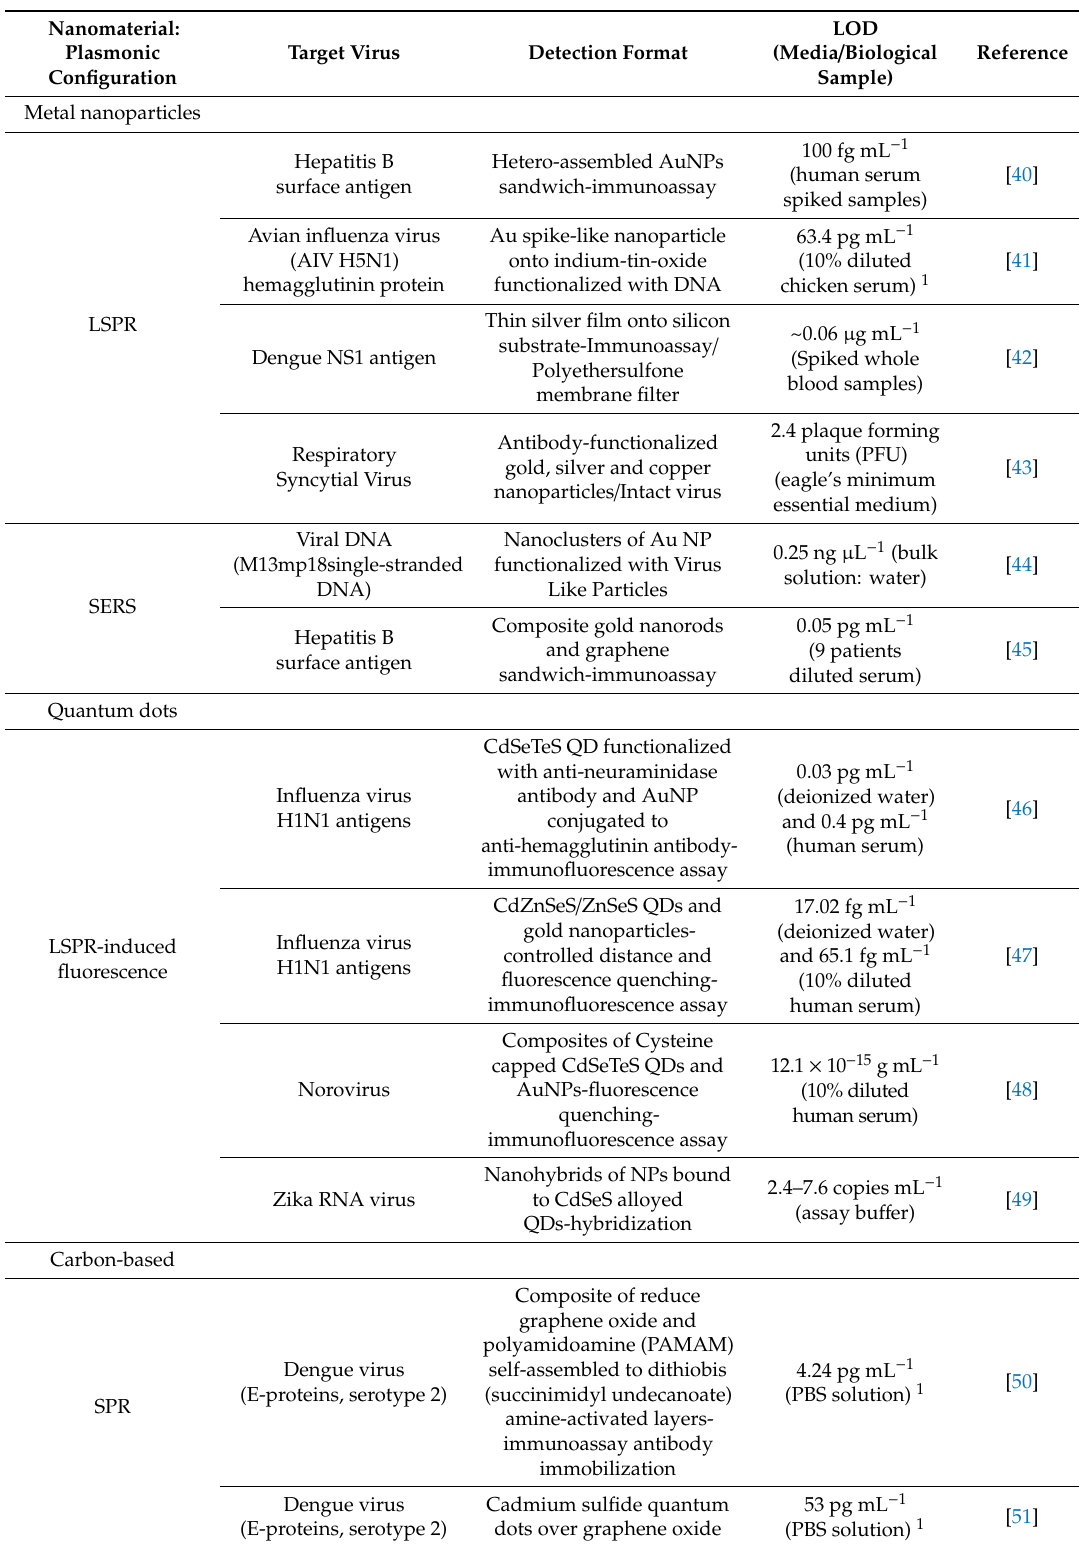
Table 1. Key analytical features of nanomaterials-based sensors classified according to the characteristics of target virus, detection format (namely immobilization strategy or biological receptor), and limit of